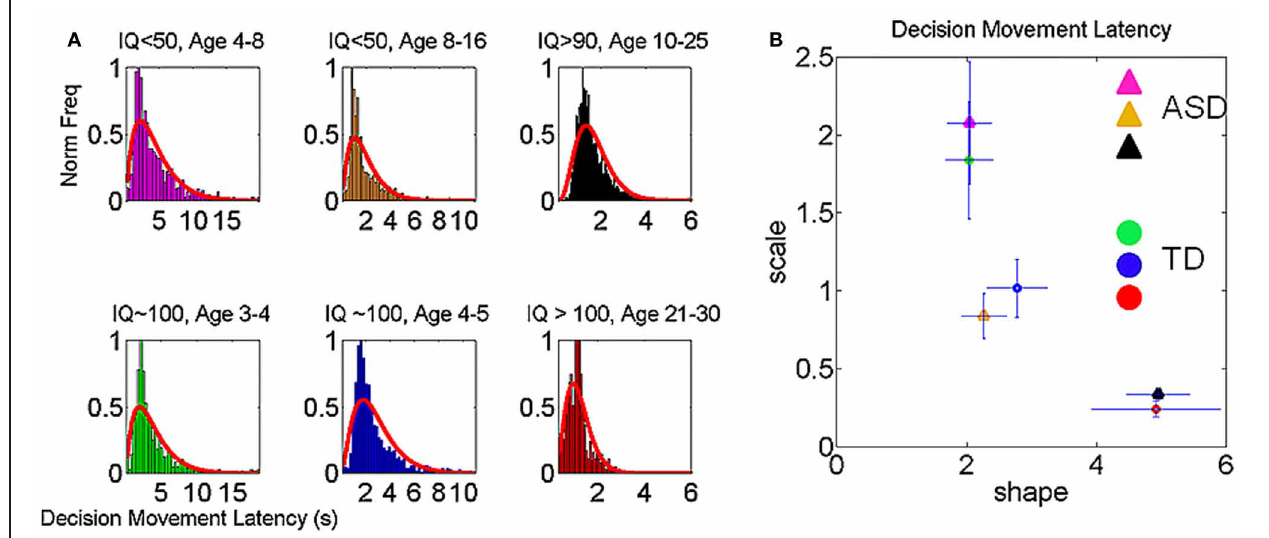
self-emerging aggregates of the velocity-dependent kinematics parameters. (B) Stochastic signatures of this parameter on the ( a,b ) Gamma plane. Notice here that 4–8 year old ASD participants are closer to the 3–4 year old TD participants than to the TD group closer to their own